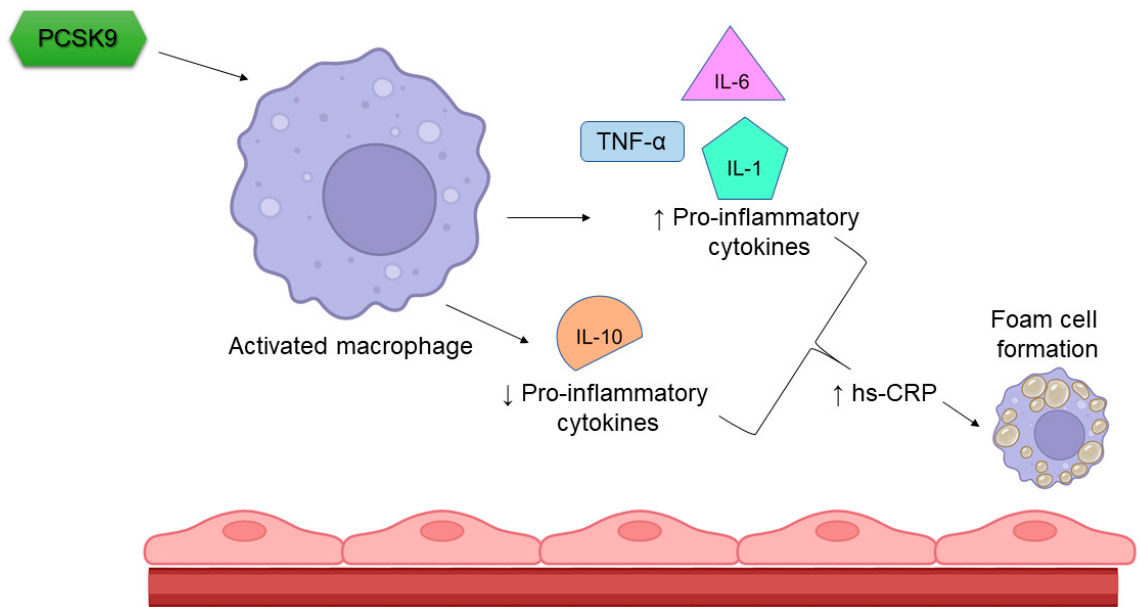
Figure 1. Influence of PCSK9 on inflammation. PCSK9 induces the expression of pro-inflammatory markers, decreases the expression of anti-inflammatory cytokines and promotes foam cell formation, all of which are the core elements of endothelial cells dysfunction and the progression of the atherosclerotic process. PCSK9—proprotein convertase subtilisin/kexin type 9, IL—interleukin, TNF- 𝛼 — tumor necrosis factor α , hs-CRP—high-sensitivity C reactive protein.